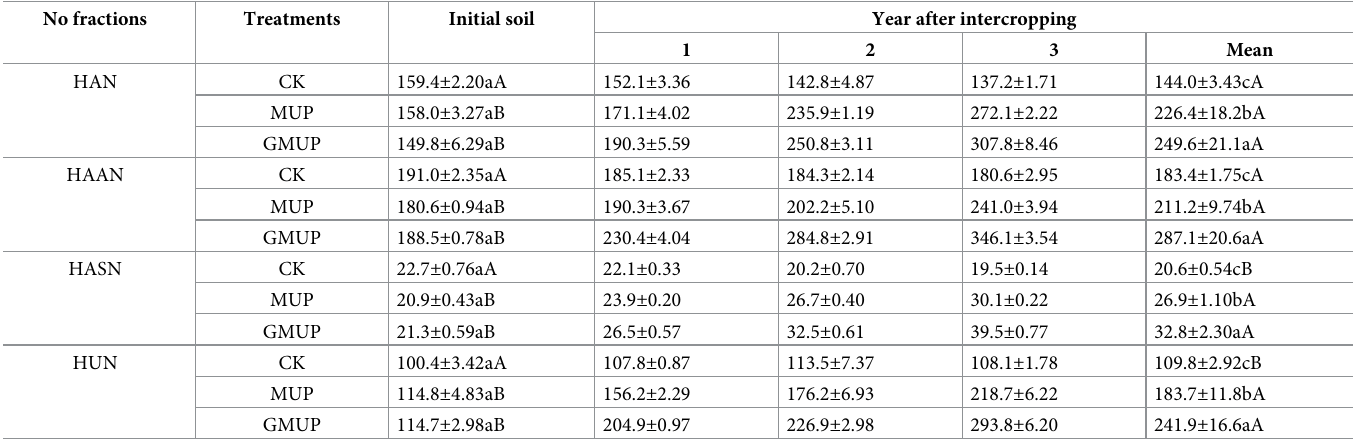
Table 3. Organic nitrogen fractions content of different treatments in the initial soil and the soil after three intercropping years (mg � kg -1 ). No fractions